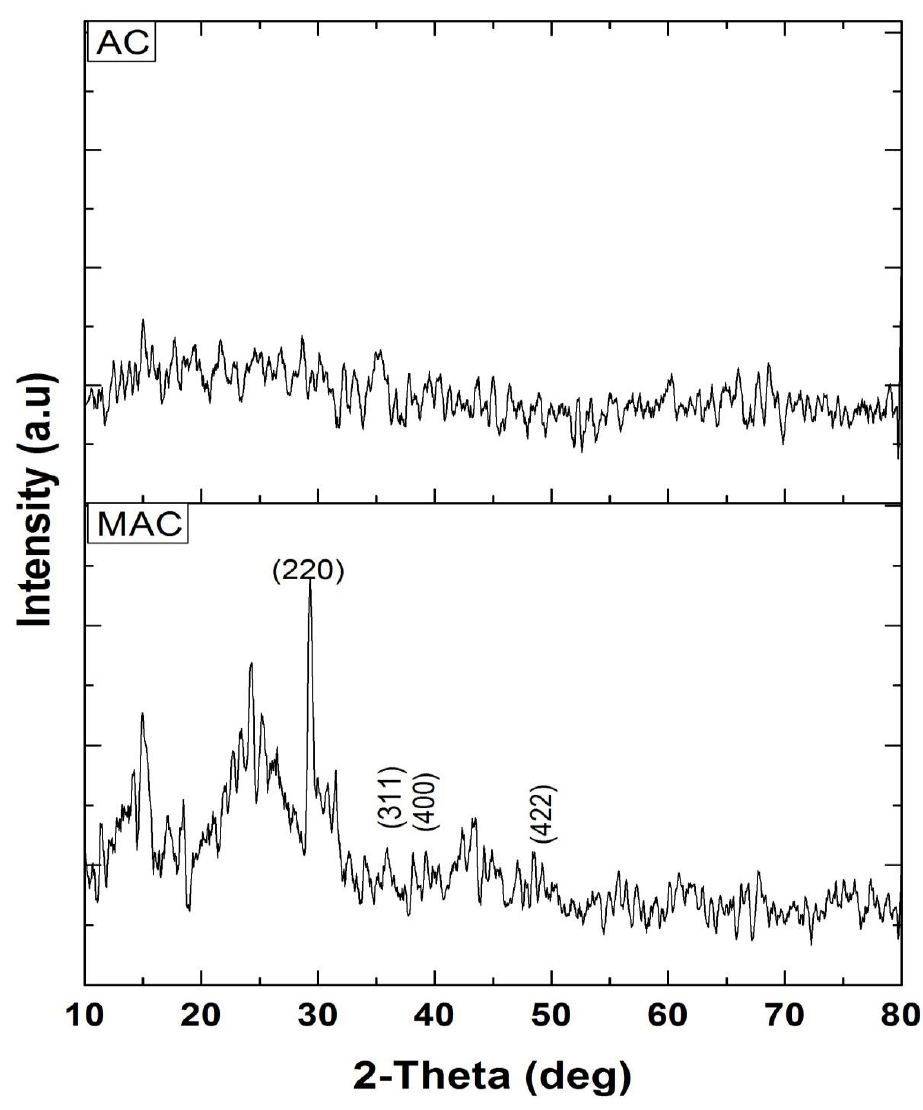
Figure 6. XRD spectrum of AC and MAC.